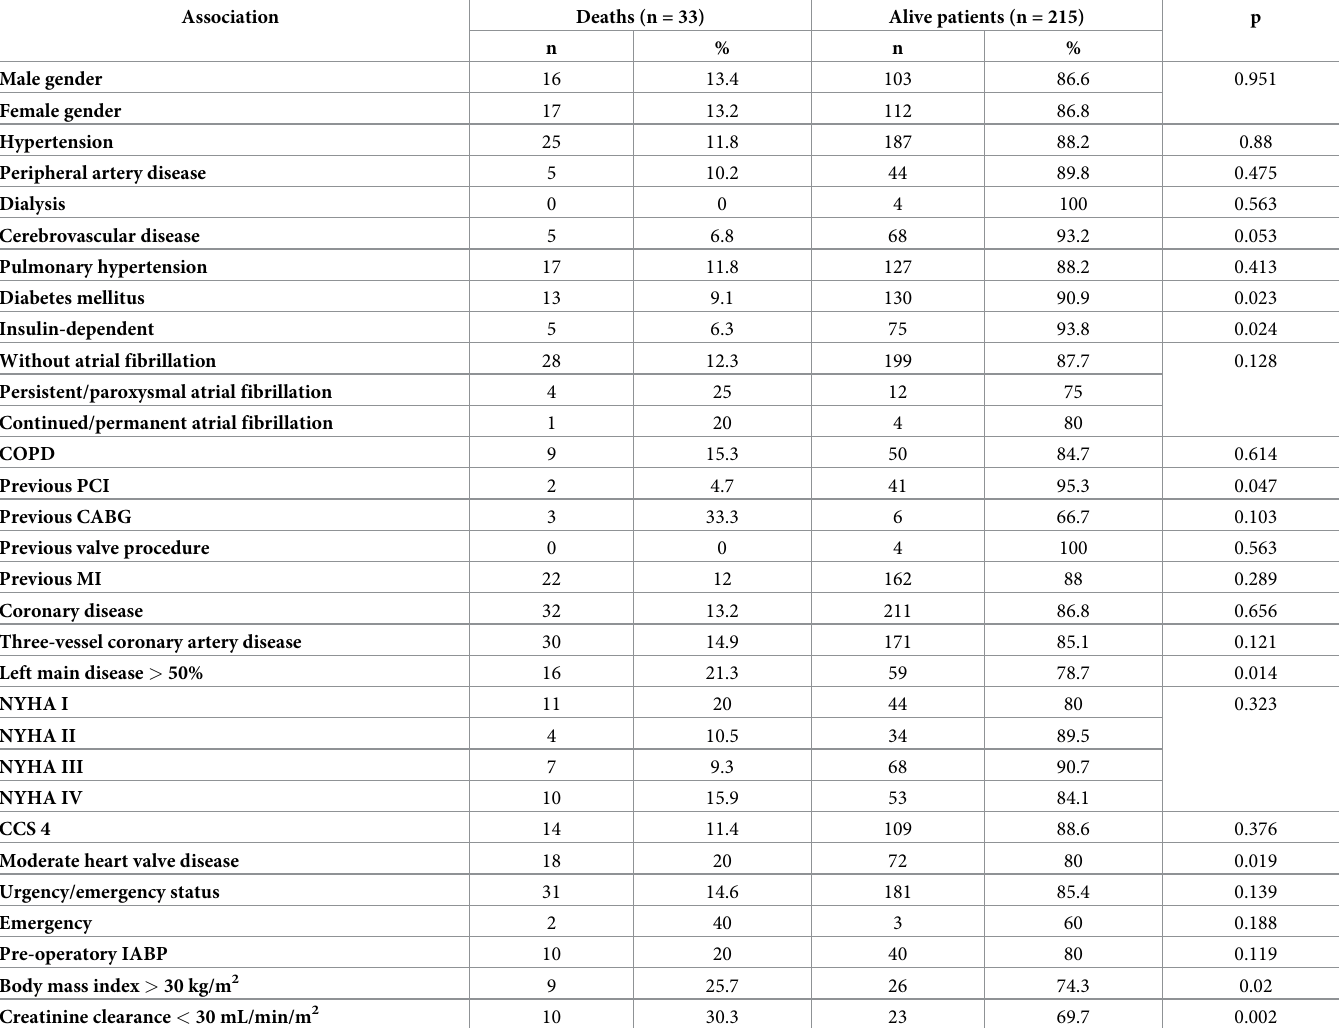
Table 2. Association analysis in the high-risk CABG